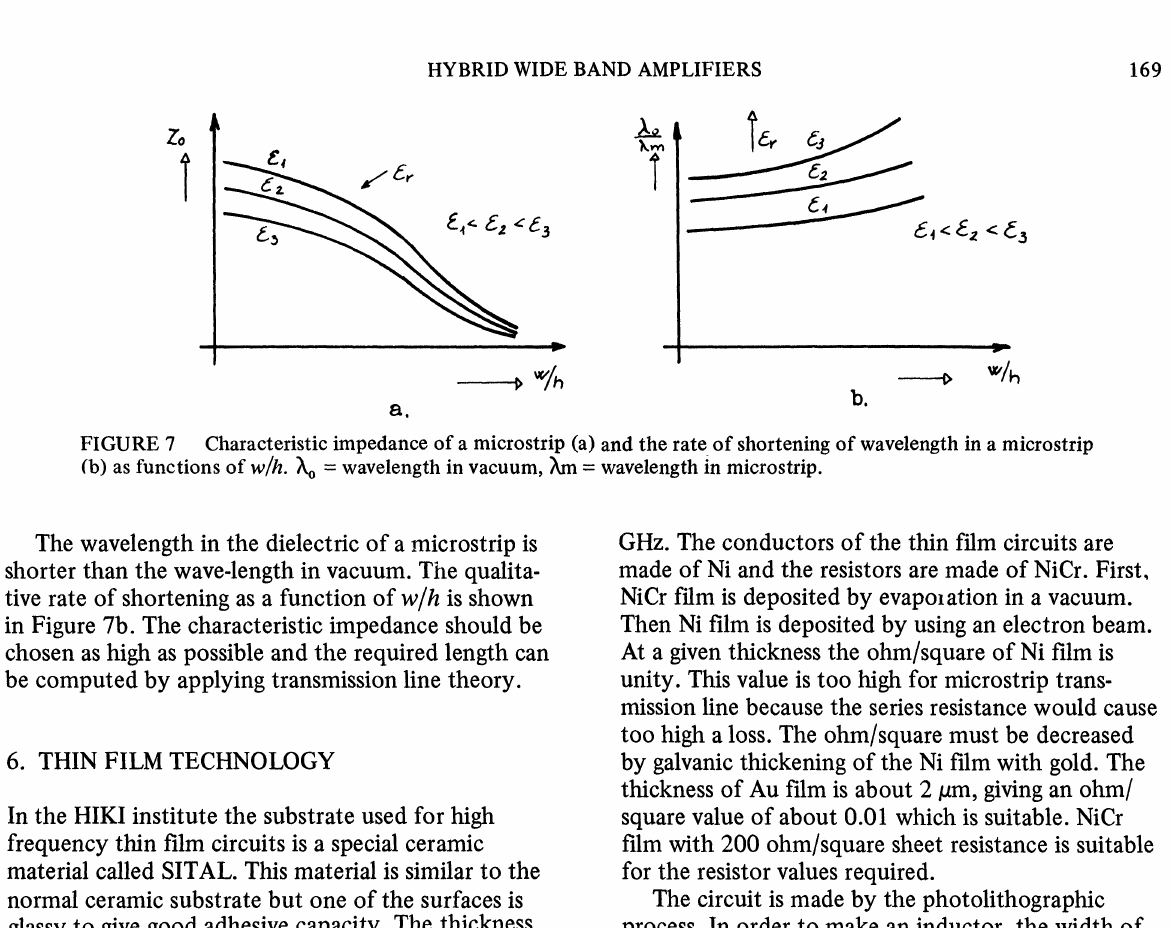
TABLE III Reference data for two kinds of wide band